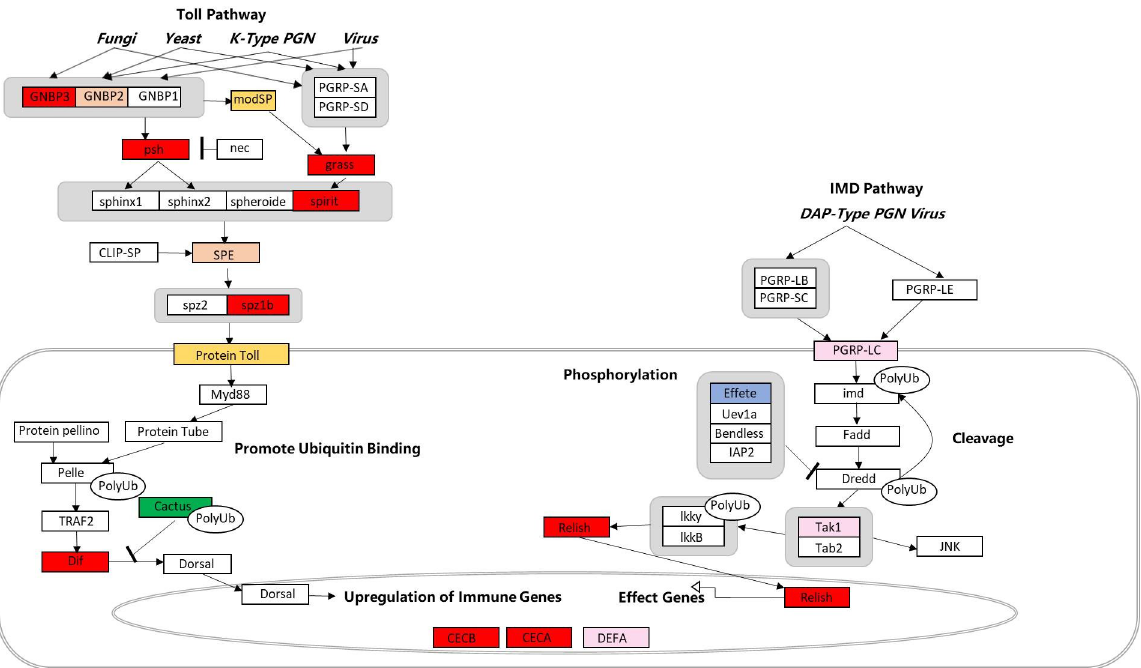
Fig 5. Regulation of putative Toll and Imd signaling pathway genes in hosts with hybrid genetic profiles. Red color indicates Toll and Imd signaling pathway genes up-regulated in both TK ♀ × NJ tet ♂ (compare to TK ♀ ) and NJ ♀ × TK tet ♂ (compare to NJ ♀ ) groups, pink color indicates up-regulated in TK ♀ × NJ tet ♂ but down-regulated in NJ ♀ × TK tet ♂ group, orange color indicates up-regulated in NJ ♀ × TK tet ♂ but down-regulated in TK ♀ × NJ tet ♂ group, green color indicates down-regulated in both TK ♀ × NJ tet ♂ and NJ ♀ × TK tet ♂ groups, yellow color indicates up-regulated only in TK ♀ × NJ tet group, blue color indicates down-regulated only in NJ ♀ × TK tet ♂ group, white indicates unfound. The pathway was built with PathVisio software 3.3.0 based on the Toll and IMD Pathways of Drosophila melanogaster downloaded from wikipathways (WP3830_92694).